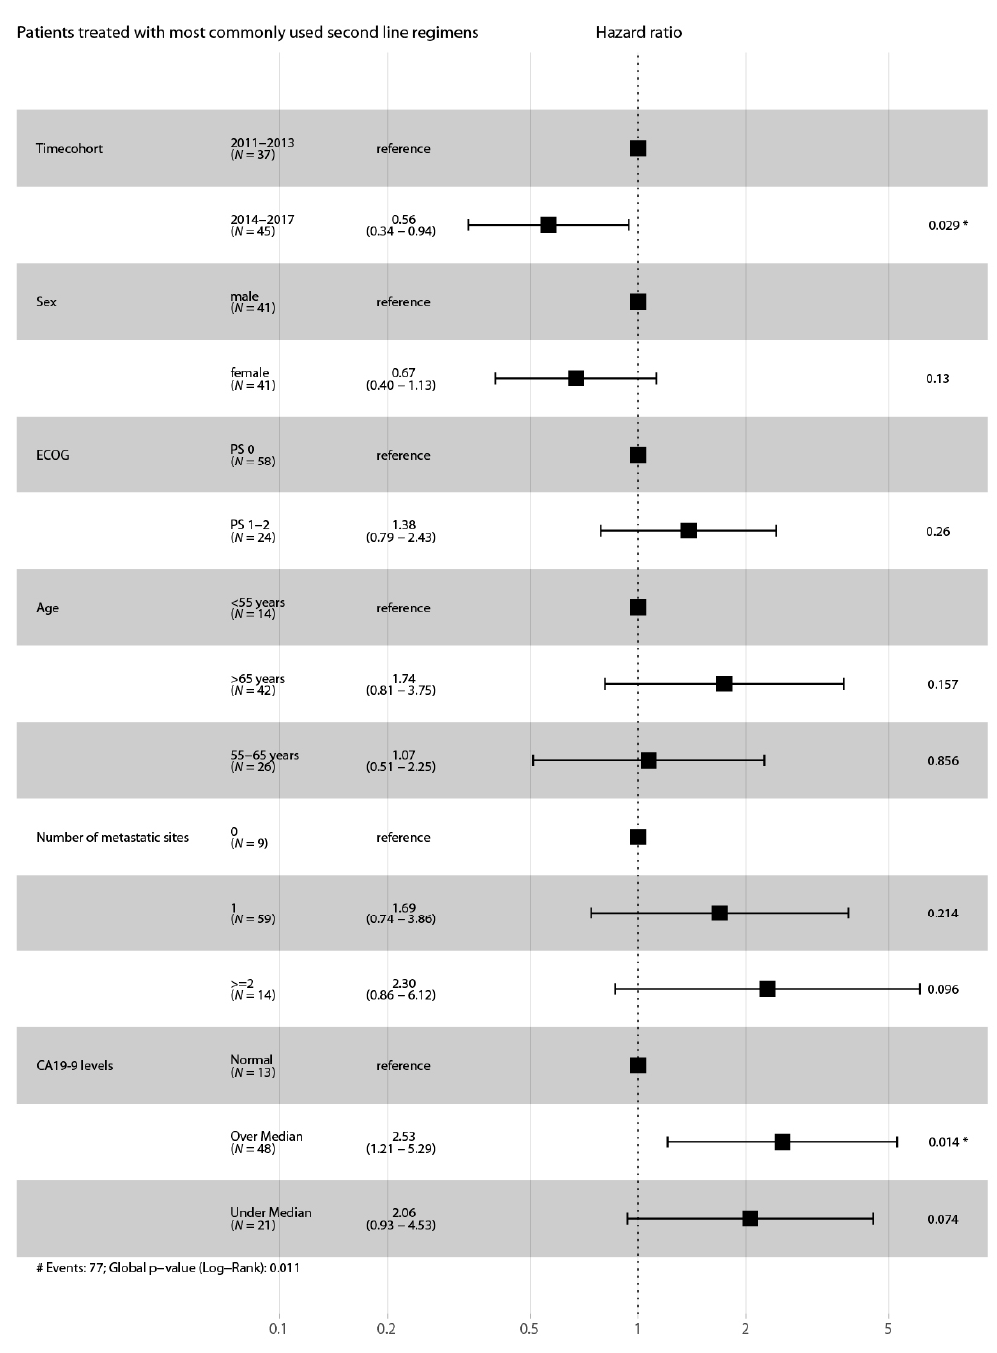
Figure 7. Forest plot for the adjusted survival analysis from patients treated with the most commonly used second line regimens of both time cohorts. Cox proportional hazard model to analyze the effect of multiple variables on the survival outcome of patients who have been treated with the most commonly used second line treatment regimens. Abbreviations: ECOG, Eastern Cooperative Oncology Group performance scale. N = 82 (patients with missing values of variables were excluded from the analysis). Asterisks indicate p -value, * 0.01 to 0.05. # indicates number. Among the total cohort, three different first to second line treatment sequences were analyzed.